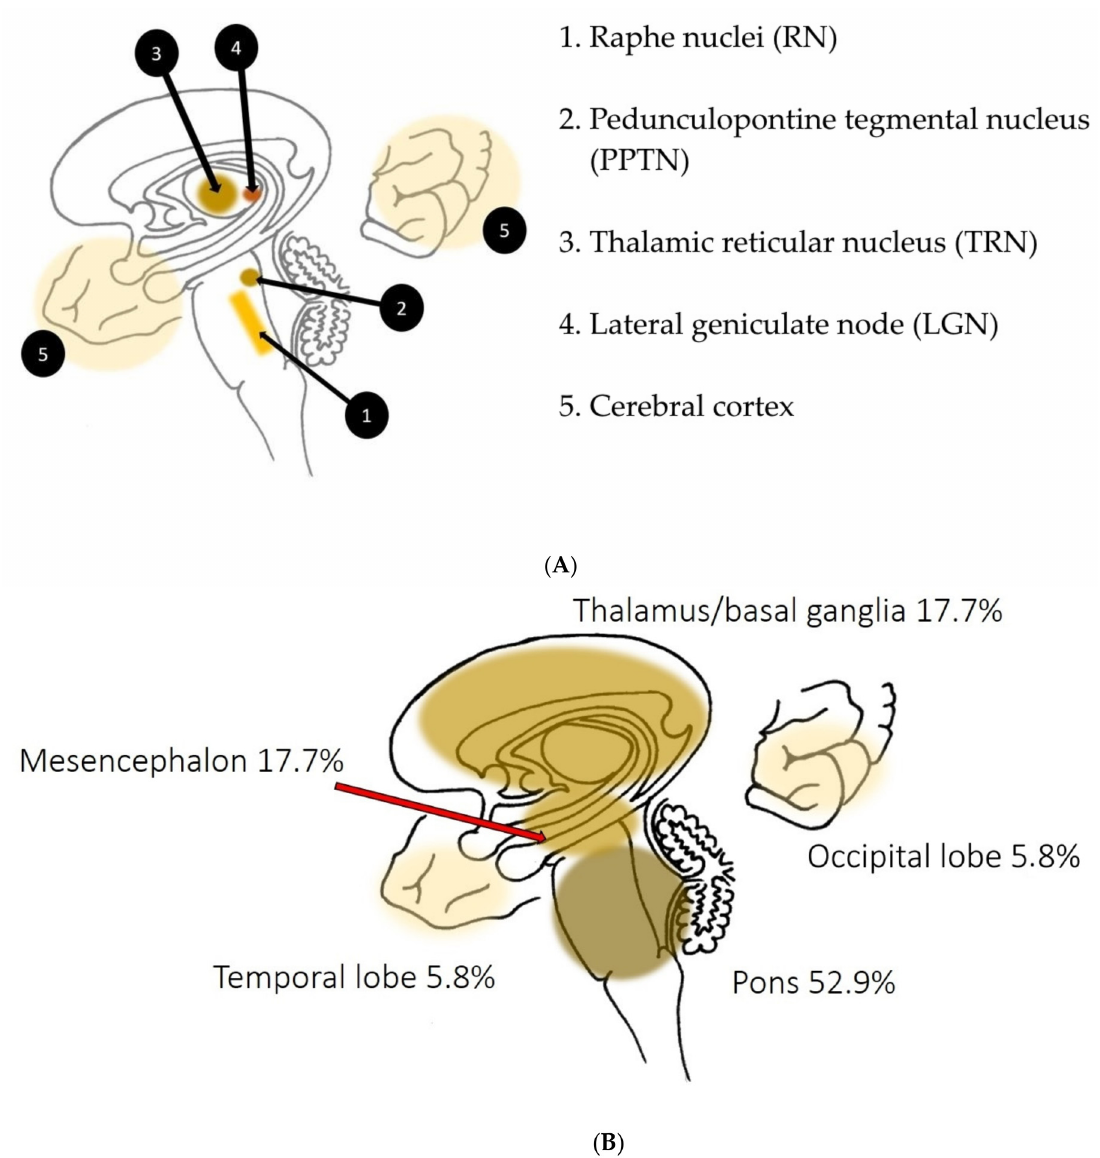
Figure 3. ( A ) Anatomy of the structures presumably involved in peduncular hallucinosis and ( B ) distribution pattern of intracerebral hemorrhages in intracerebral hemorrhage-related peduncular